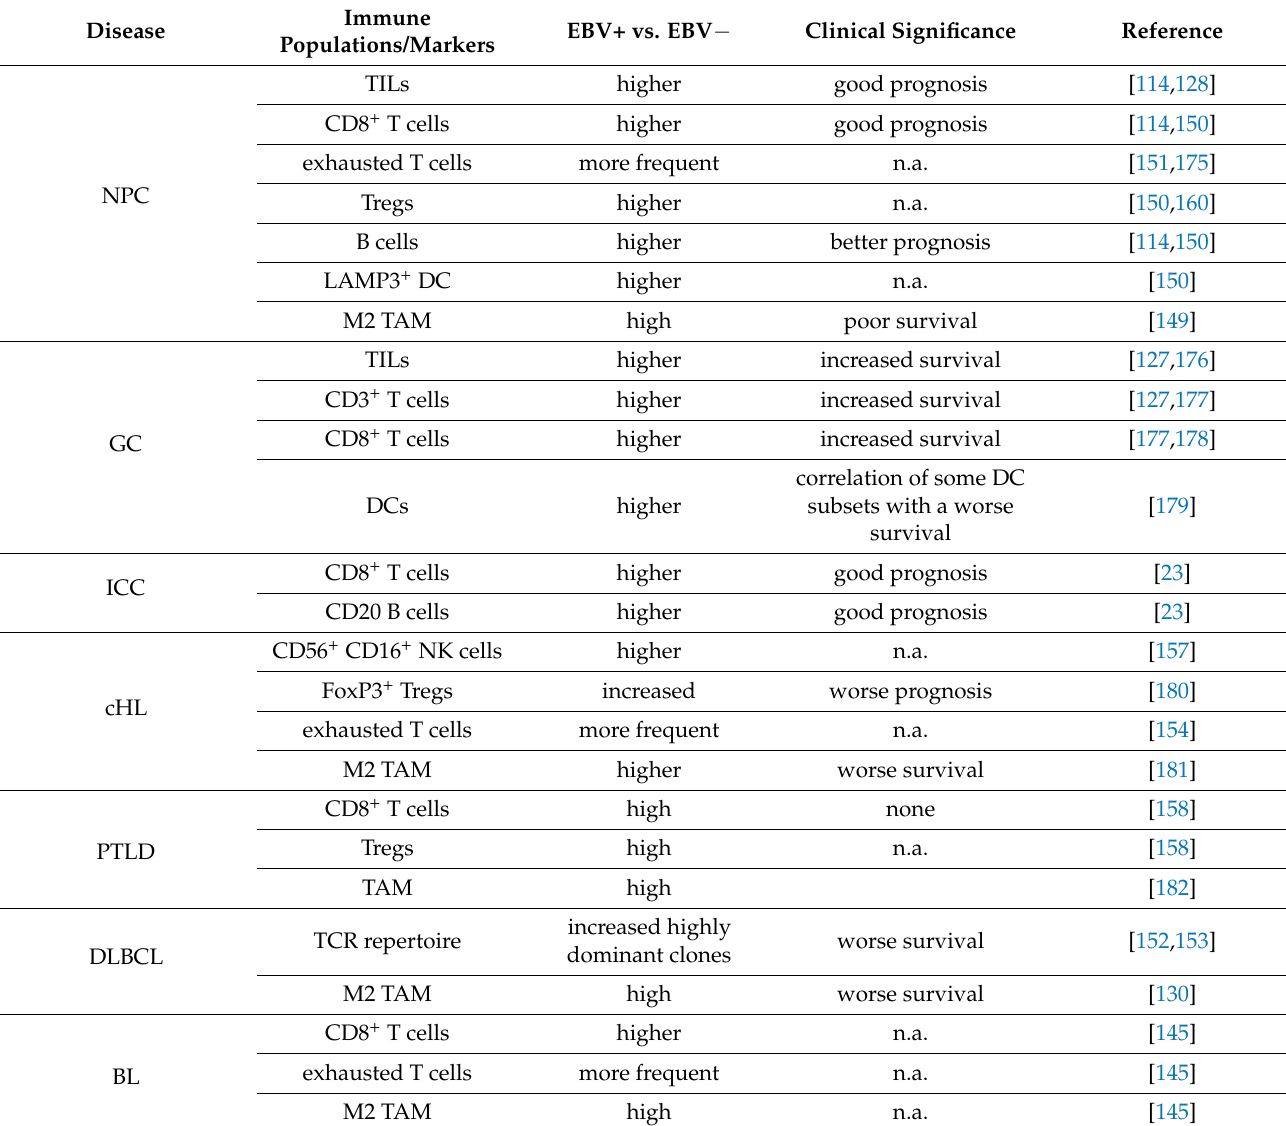
Table 4. Differences of the frequency of immune cell subpopulations in the TME in EBV-positive vs. EBV-negative malignancies and their clinical significance. Abbreviations: DC: dendritic cell; n.a. not available; NK cell, natural killer cells; TAM, tumor-associated macrophage; TIL, tumor-infiltrating lymphocyte; Treg, regulatory T cell.